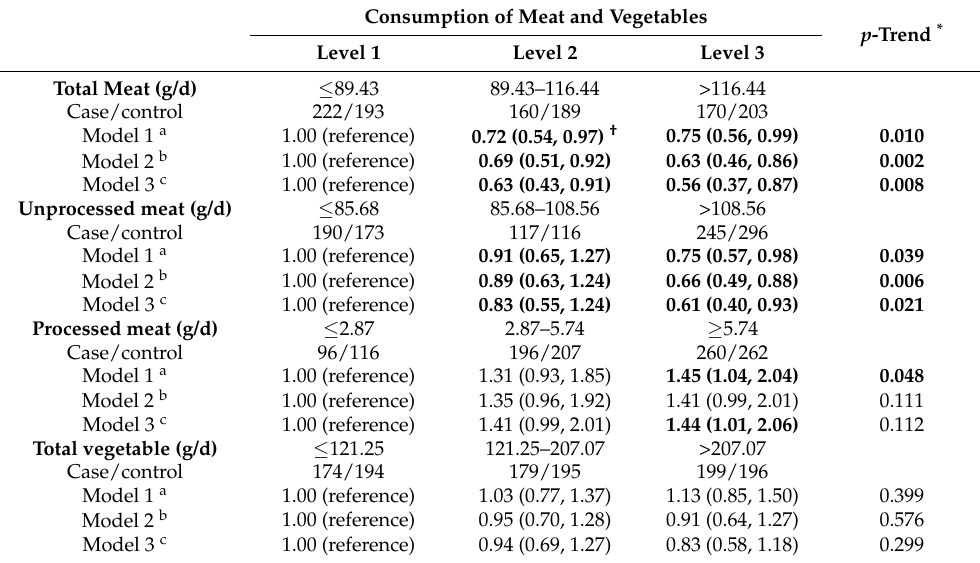
Table 2. Associations between meat and total vegetable intake and the asthenozoospermia risk. Consumption of Meat and Vegetables